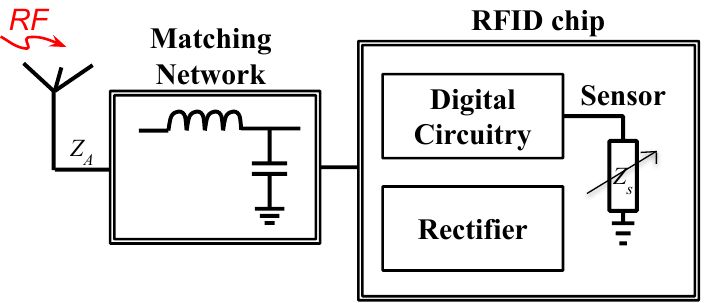
Figure 11. A simple block diagram of a chip-based digitally interfaced